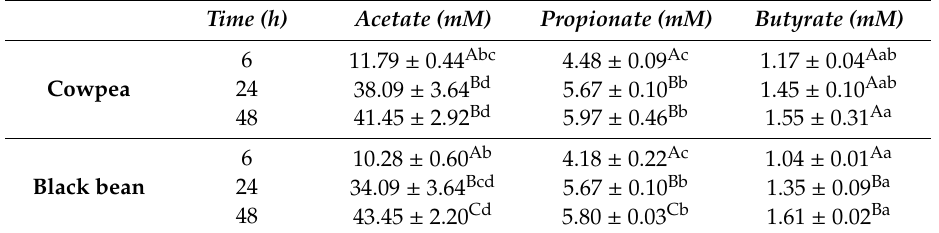
Table 3. Production of short-chain fatty acids (SCFA) during the fermentation time of 6, 24 and 48